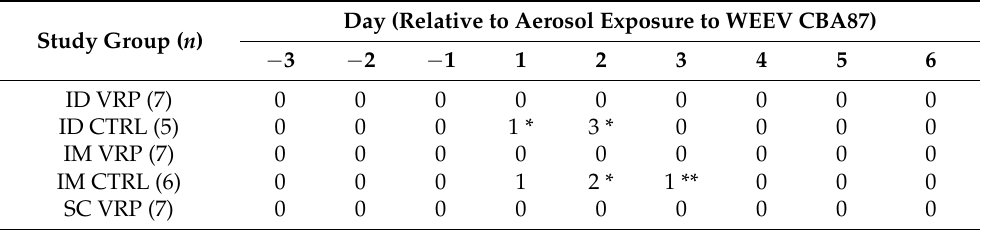
Table 1. Number of NHPs with Detectable Amplification above Lower Limit of Detection of WEEV CBA87 Viral RNA in the Blood by RT-PCR. Day (Relative to Aerosol Exposure to WEEV CBA87) Study Group ( n )